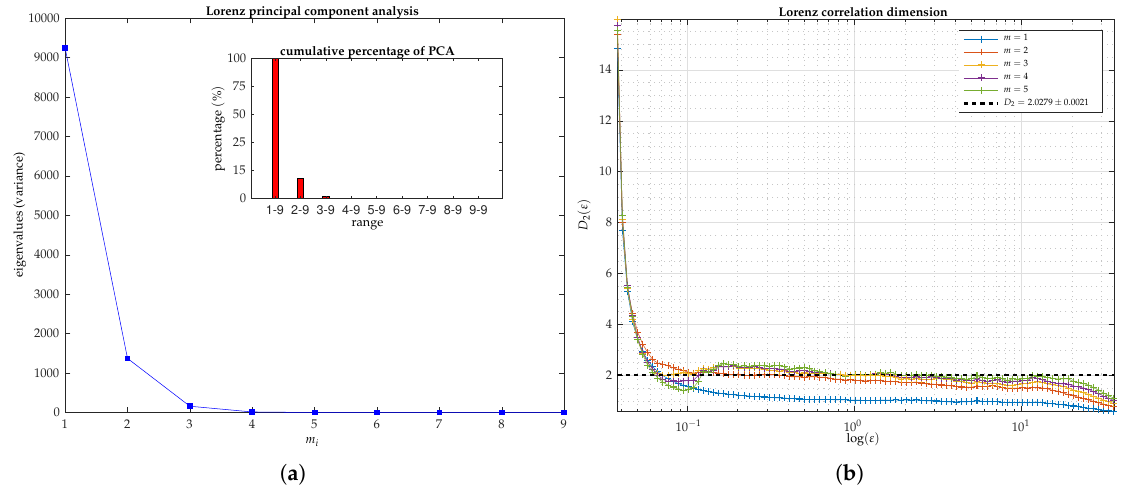
Figure 8. From the dynamic variable x of the Lorenz attractor: ( a ) principal component analysis (PCA). The inner box clearly shows how the dynamic behavior of the attractor can be characterized with only three directions. ( b ) Correlation dimension ( D 2 ). It can be seen how from m = 3, the correlation dimension is confined to a constant value in an intermediate and reduced range of scales ε